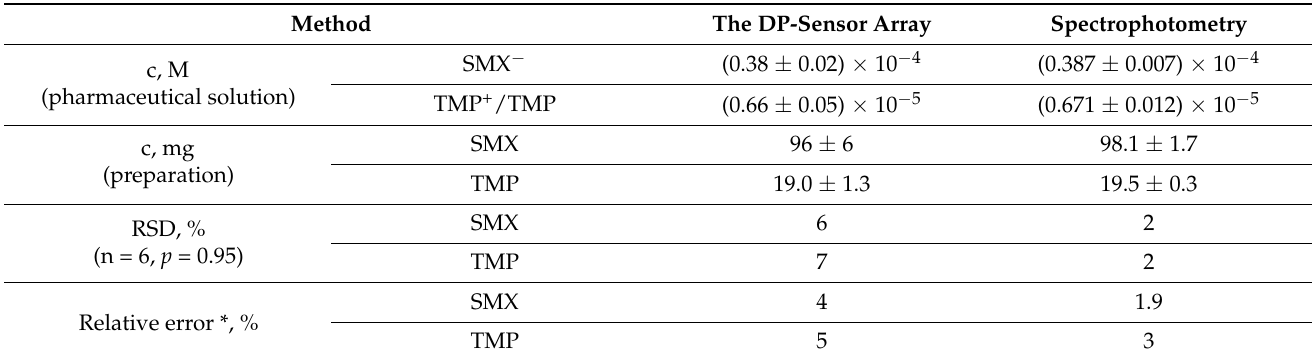
Table 3. The characteristics of the SMX − and TMP + /TMP determination in the model solutions ( с = 1.0 × 10 −5 – 1.0 × 10 −3 М, рН 4.53– 8.31) using the array of DP-sensors based on MF-4SC/1.0 wt% CNTs- SO 3 − and MF-4SC/1.0 wt% CNTs-NH 3+ membranes.